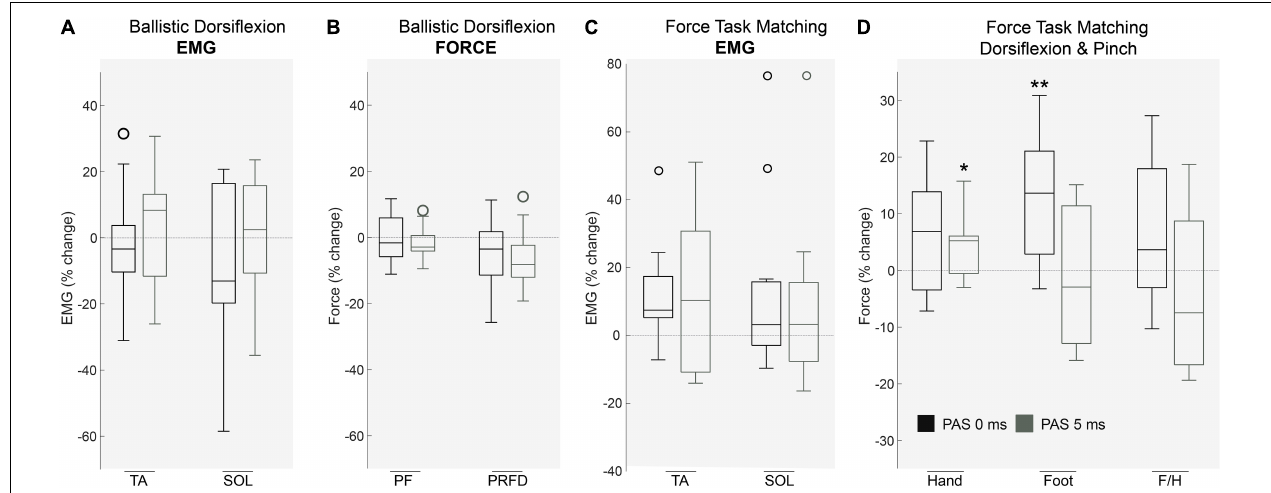
FIGURE 4 | The effects of PAS on voluntary motor tasks. During ballistic dorsiflexion both muscle activation of (A) agonist/antagonist muscles and force including (B) Peak Force (PF) and Peak Rate of Force Development (PRFD) were unaffected by PAS protocols ( p > 0.05, n = 11). During a force-task matching exercise (pinch and dorsiflexion) Muscle EMG (C) remained unaffected ( p > 0.05, n = 11), however, (D) Force production was significantly affected ( p < 0.01, n = 11) in the hand after PAS 5Ms ( p < 0.05) and in the foot after PAS 0Ms ( p < 0.01). Each box indicates the Upper (25 percentile) and Lower (75 th percentiles), the whiskers represent the minimum and maximum values, the central line is median value and open circles represent outliers (values that are more than 1.5 of the interquartile range away from the top or bottom of the box). * P < 0.05 ** P <